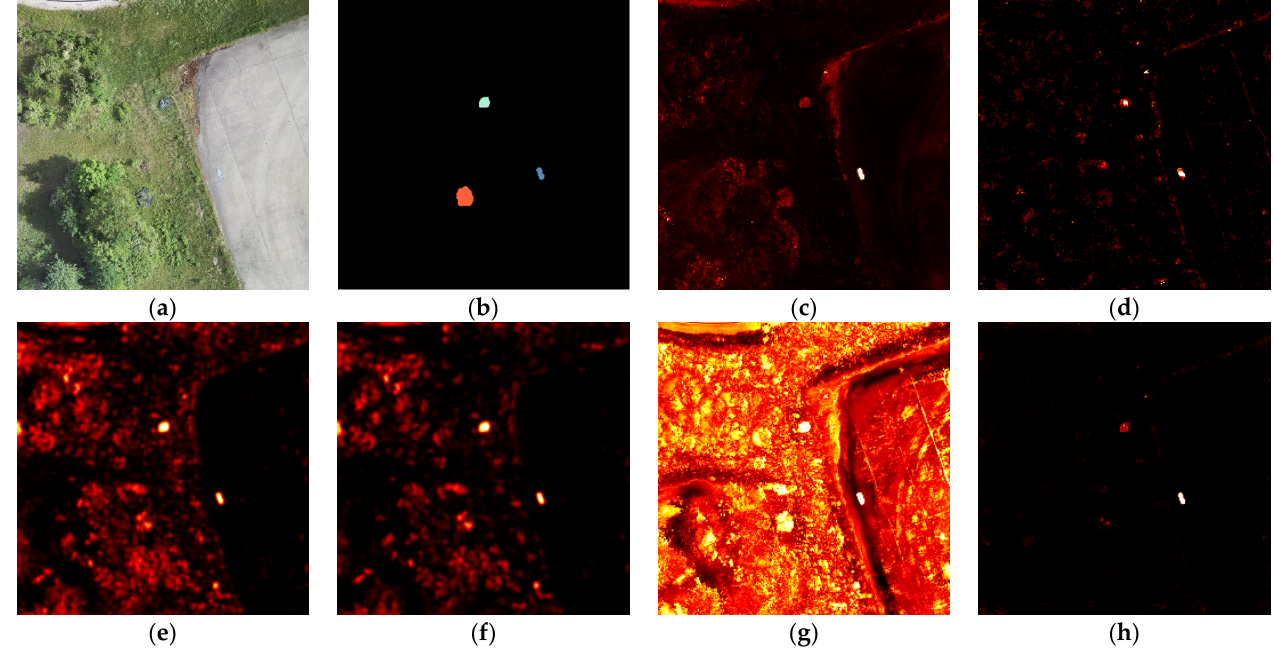
Figure 10. Detection maps of all evaluated methods applied on an exemplary capture of the extended version of MUCAD (MUCAD-VI). ( a ) VIS; ( b ) ground truth; ( c ) RX; ( d ) LRX (21, 61); ( e ) AED (200); ( f ) AED-F (200); ( g ) LPD (11, 31); ( h ) CRD (21, 31). The parameter configurations (in parentheses) corresponds either to the inclusion and exclusion window or to the area of connected components to be removed.